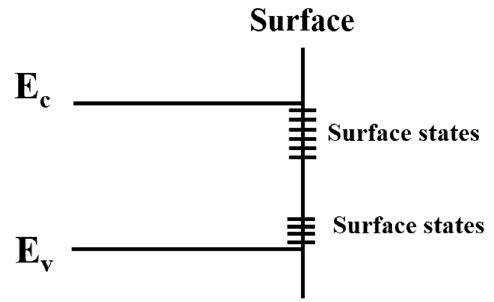
Figure 1. Schematic diagram of surface level.